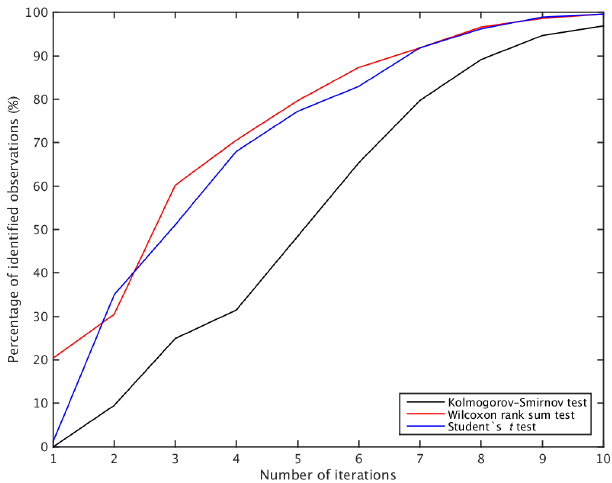
Figure 4. Comparison of clusters identification rates depending on an employed statistical